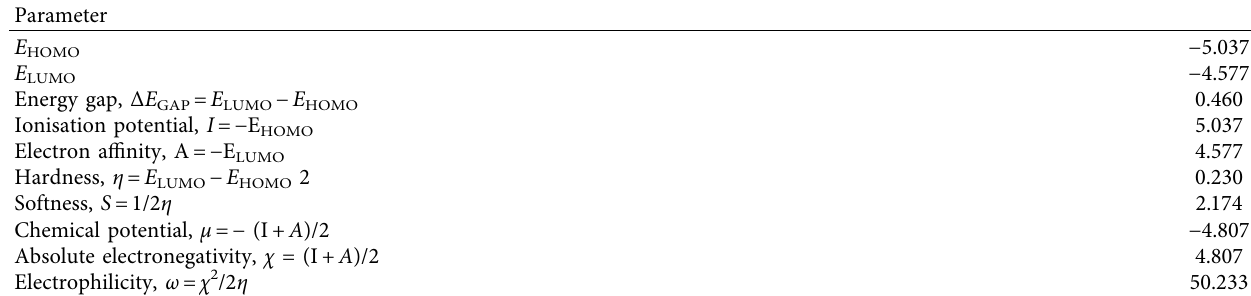
Table 4: Reactivity descriptors (in eV) of NiL